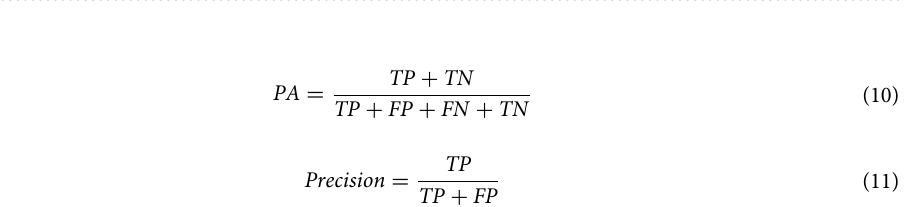
Table 1. Comparison of experimental results of feature extraction